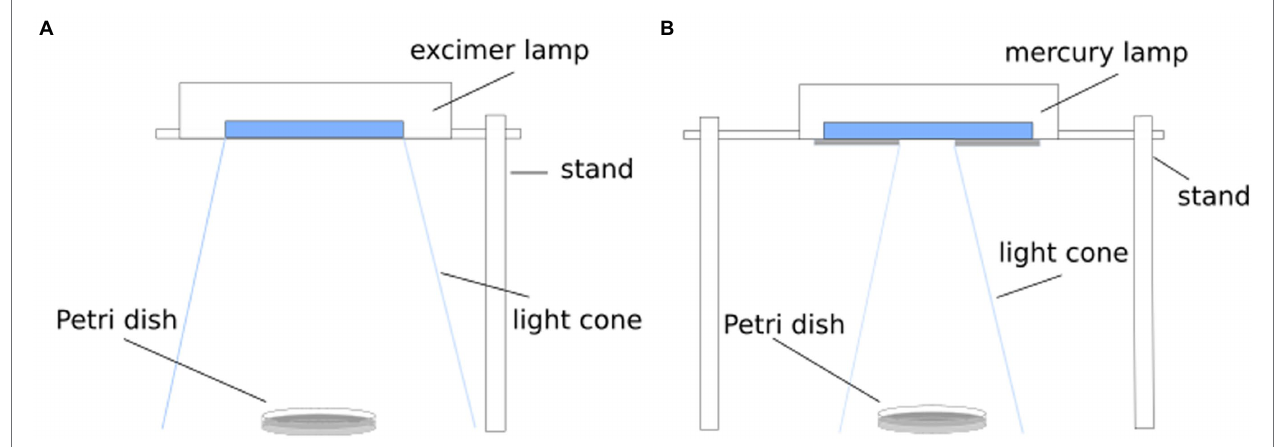
FIGURE 1 | Schematic setup for inactivation experiment. For radiation of 222 nm, a KrCl excimer lamp was applied (A) and a mercury vapor lamp was used for a radiation wavelength of 254 nm (B)